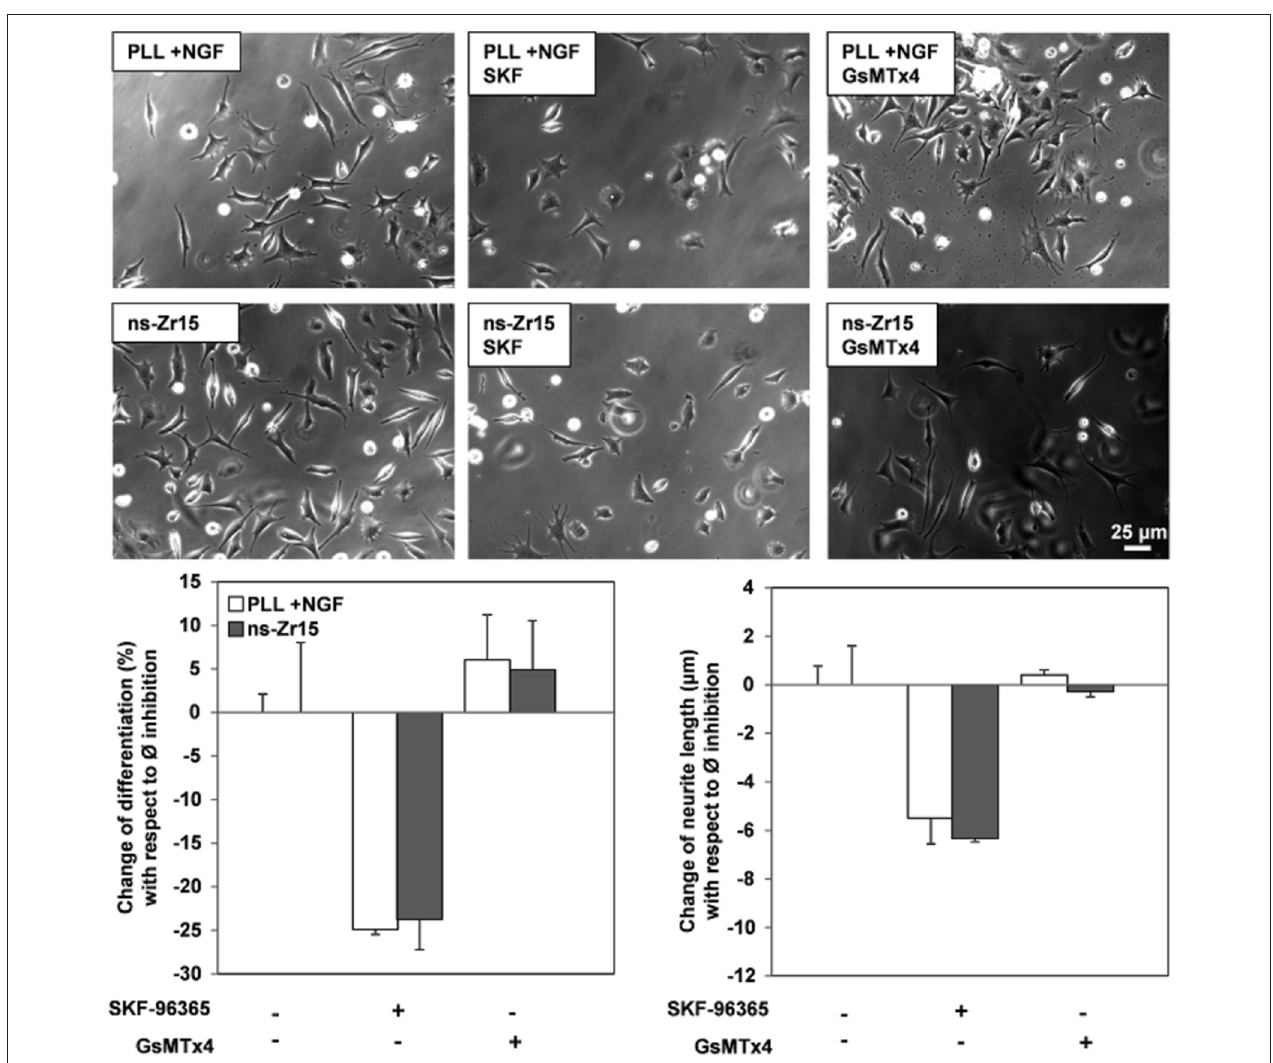
FIGURE 6 | Impact of treatment with drugs affecting different types of calcium channels (SKF-96365 and GsMTx4). The phase contrast and the graph show the effect of the drugs SKF-96365 (15 µ M) and GsMTx4 (10 µ M), affecting transient receptor potential cation channels (TRPC), respectively stretch-activated channels (SAC), on PC12 differentiation grown in the PLL + NGF and ns-Zr15 condition. The graph represents the global statistics of two independent experiments with the change of differentiation rate (left graph) and neurite length (right graph) in comparison to the corresponding condition Ø inhibition (white bars: PLL + NGF, gray bars: ns-Zr15). The bars represent the average (mean ± s.d.) of the two experiments (comprising in total 434–650 cells and 108–387 neurites